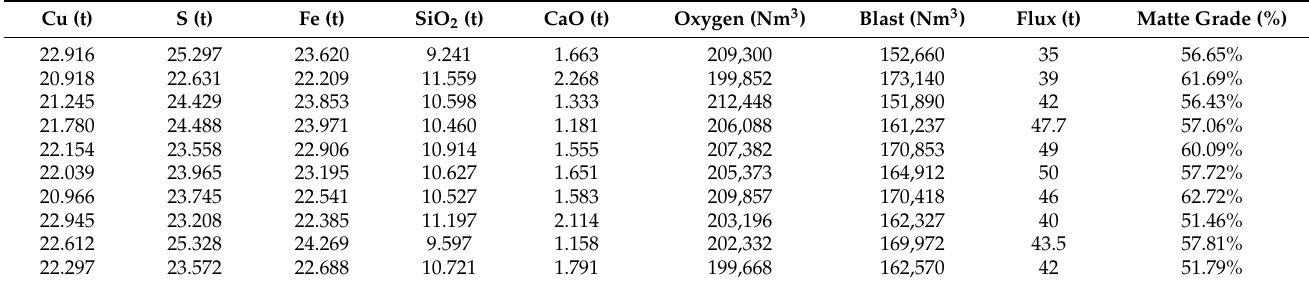
Table 1. Ten groups of training samples taken from a copper smelting enterprise.